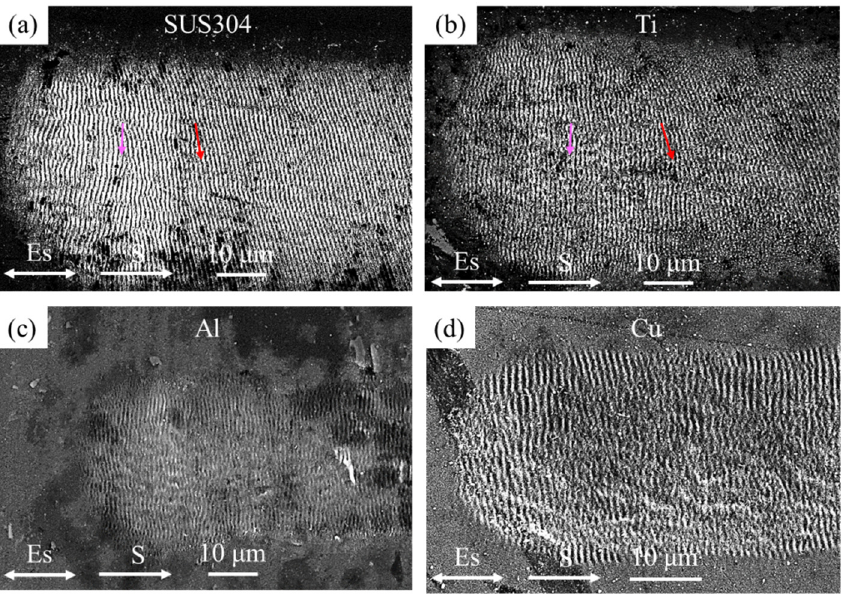
Figure 3. SEM images of the line scanning start regions for four materials with θ = 30 ◦ ; ( a ) SUS304, ( b ) Ti, ( c ) Al, and ( d ) Cu. Table 1. Summary of LSFL experimental results and material related optical and thermal parameters.